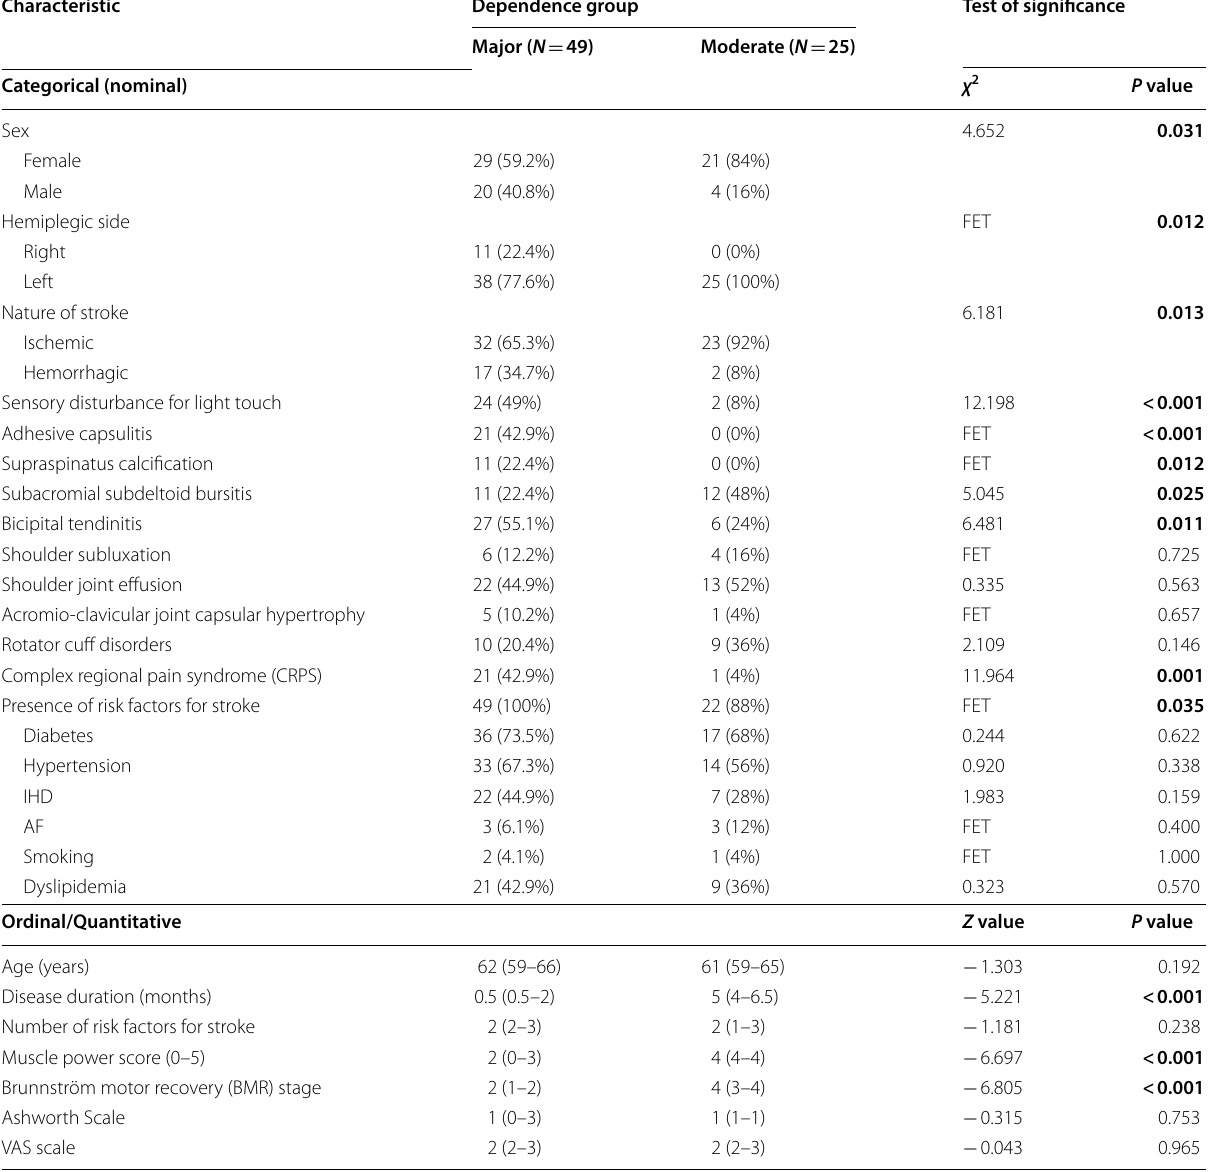
0–55) and moderate dependence (BIS =